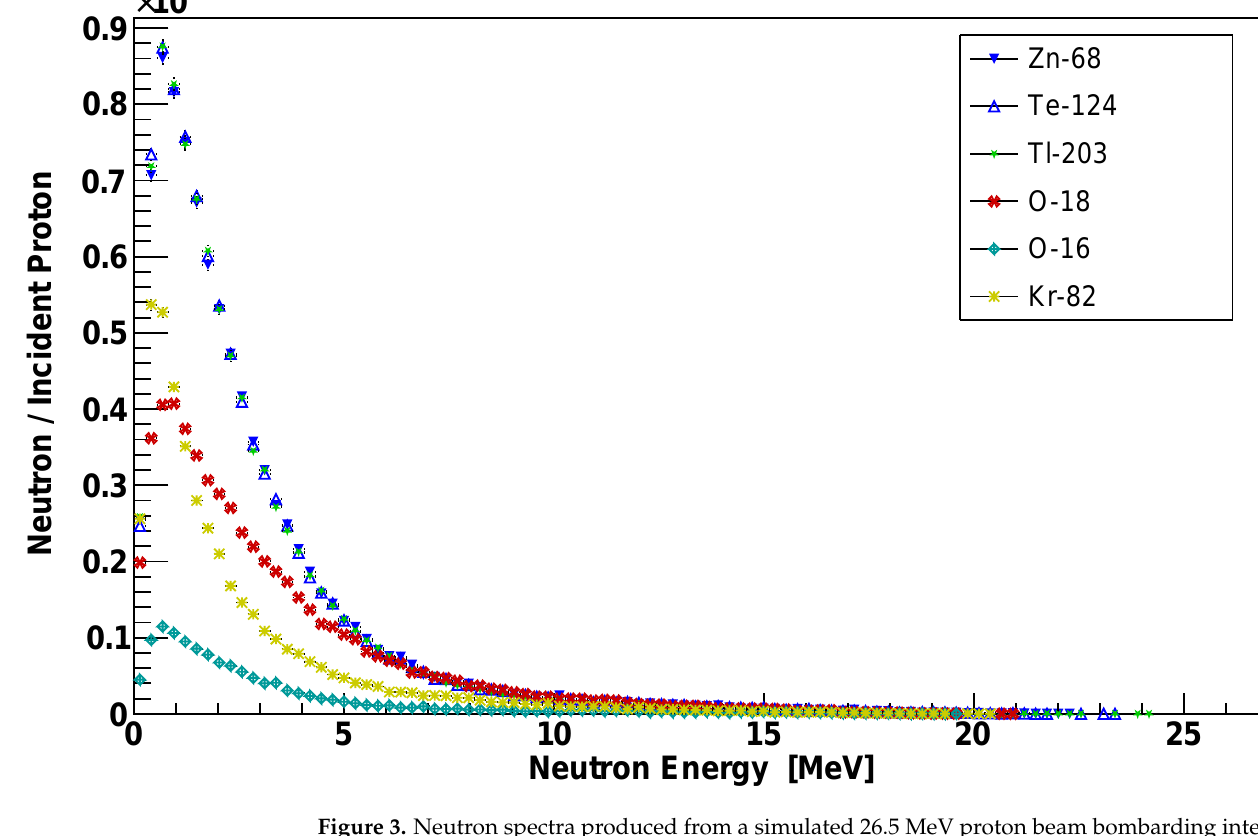
Figure 3. Neutron spectra produced from a simulated 26.5 MeV proton beam bombarding internal and external